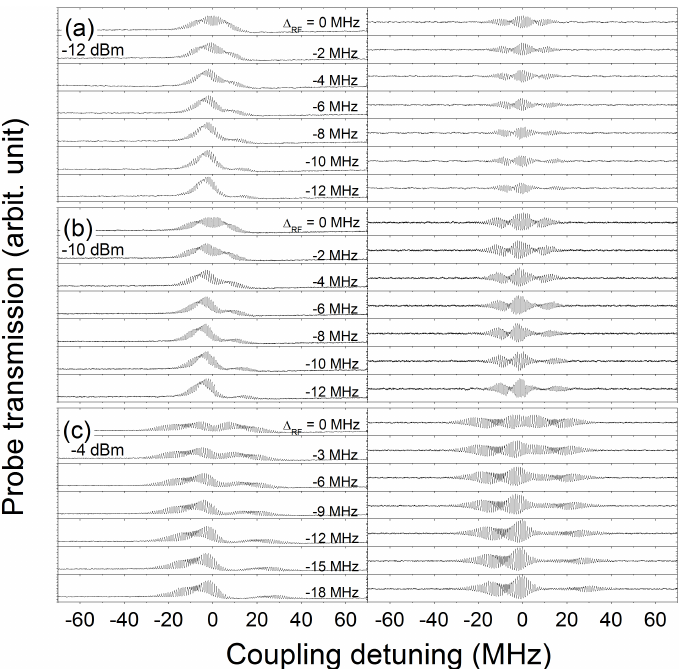
Figure 7. The measurement of optical response of MW at different RF frequency detunings ( left ) and its dynamical signal extraction ( right ) at various LO field power (a) -12 dBm, (b) -10 dBm and (c) -4 dBm. A moderate detuning can increase the dynamical signal. The laser powers are fixed at the optimized